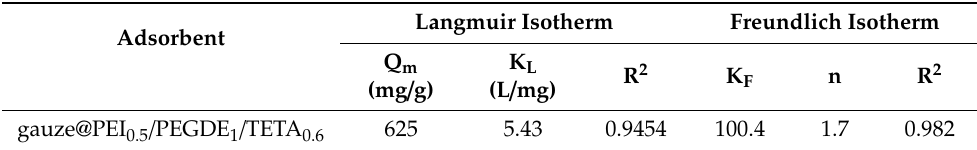
Figure 6. Adsorption isotherms of gauze@PEI 0.4 /PEGDE 1 /TETA 0.6 based on ( a ) the Langmuir isotherm model and ( b ) the Freundlich isotherm model. Table 1. Freundlich and Langmuir isotherm constants.